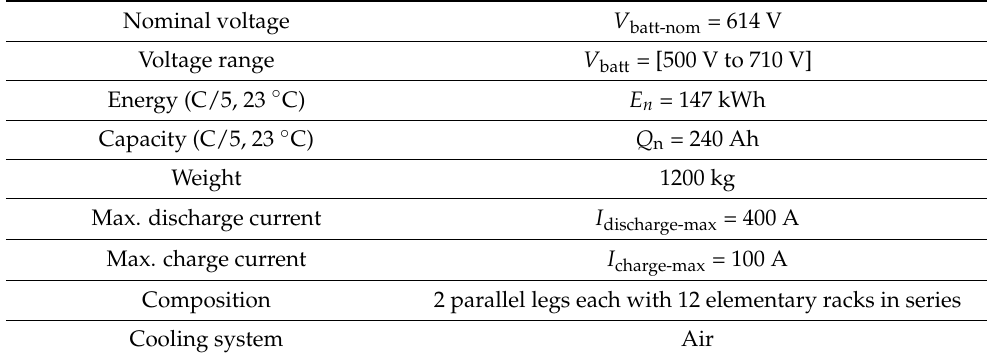
Figure 2. Isolated DC/DC converter: principle of an elementary block of the current prototype.